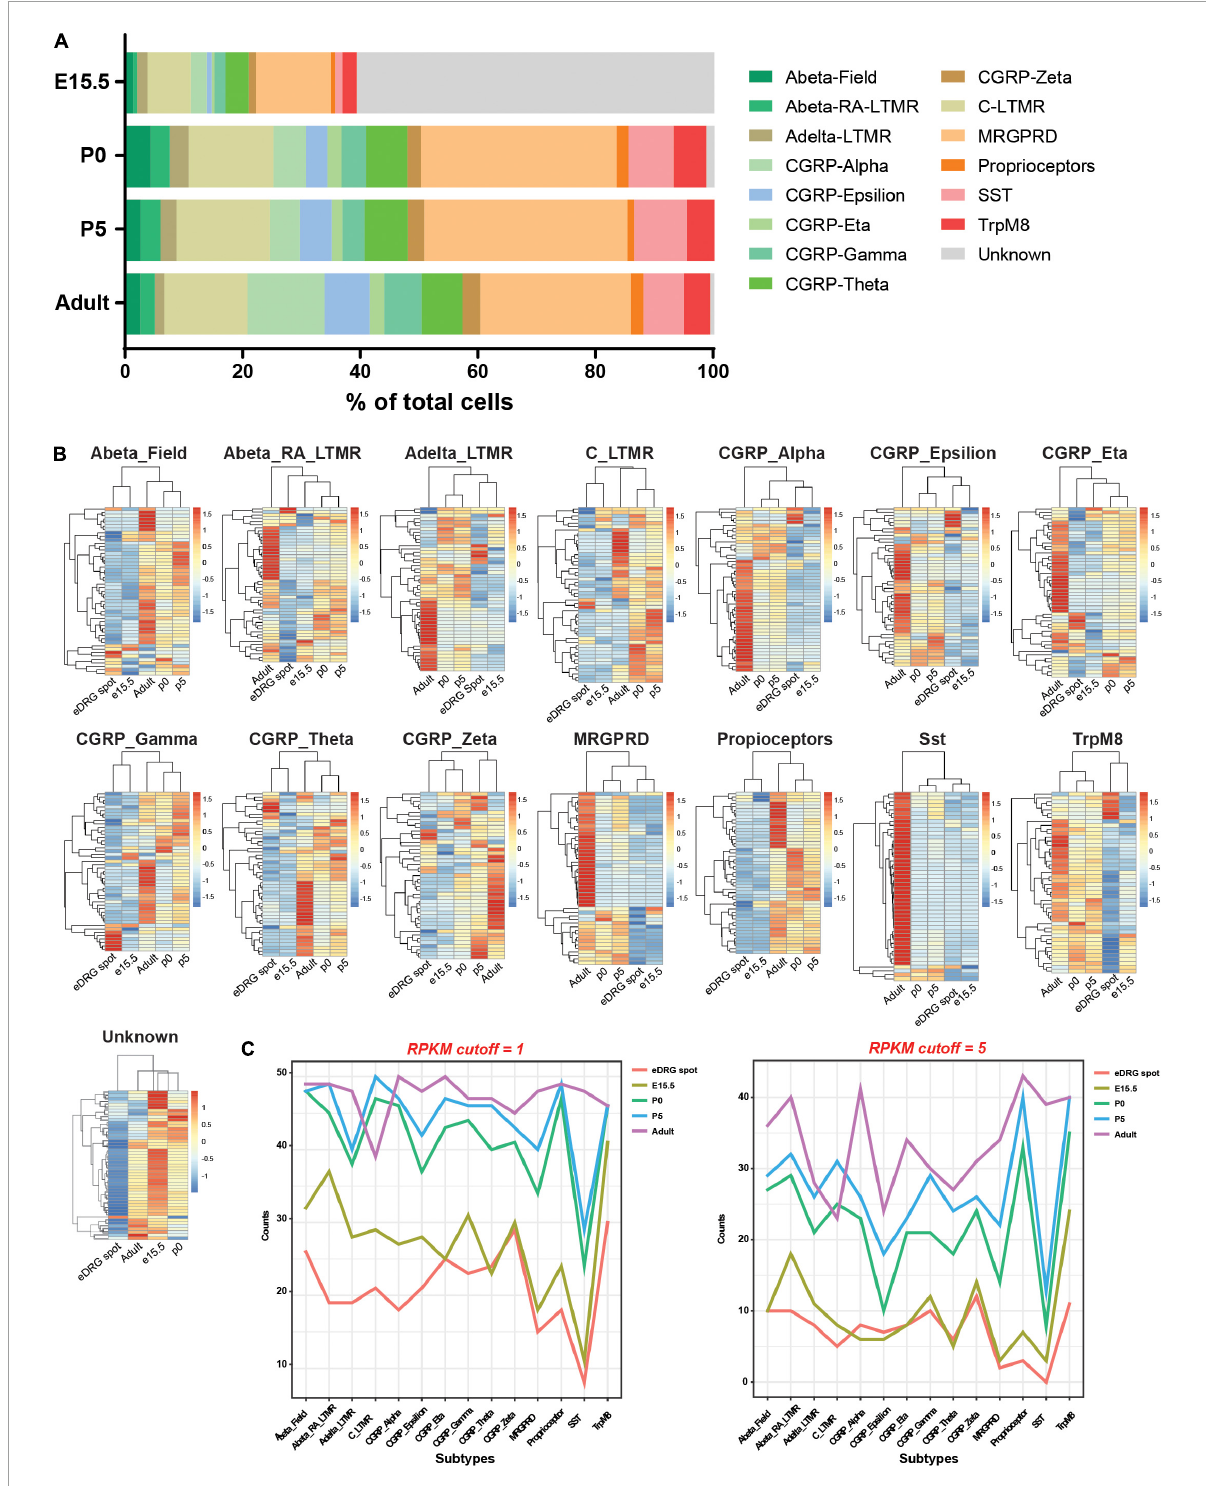
FIGURE2 Neurons in the eDRG at DIV7 are similar to DRG neurons at the E15.5 developmental stage. (A) Fraction of 15 neuronal subtypes across four developmental stages of DRG neurons. (B) Heatmap shows the scaled z -score of the average CPM of 50 subtype-specific genes from eDRG controls and 4 developmental stages. Both row and column clustering were applied. High and low expressions are indicated in red and blue, respectively. (C) Plots of the counts of 50 subtype-specific genes expressed in each neuronal subtype during development using RPKM with cutoffs of 1 and